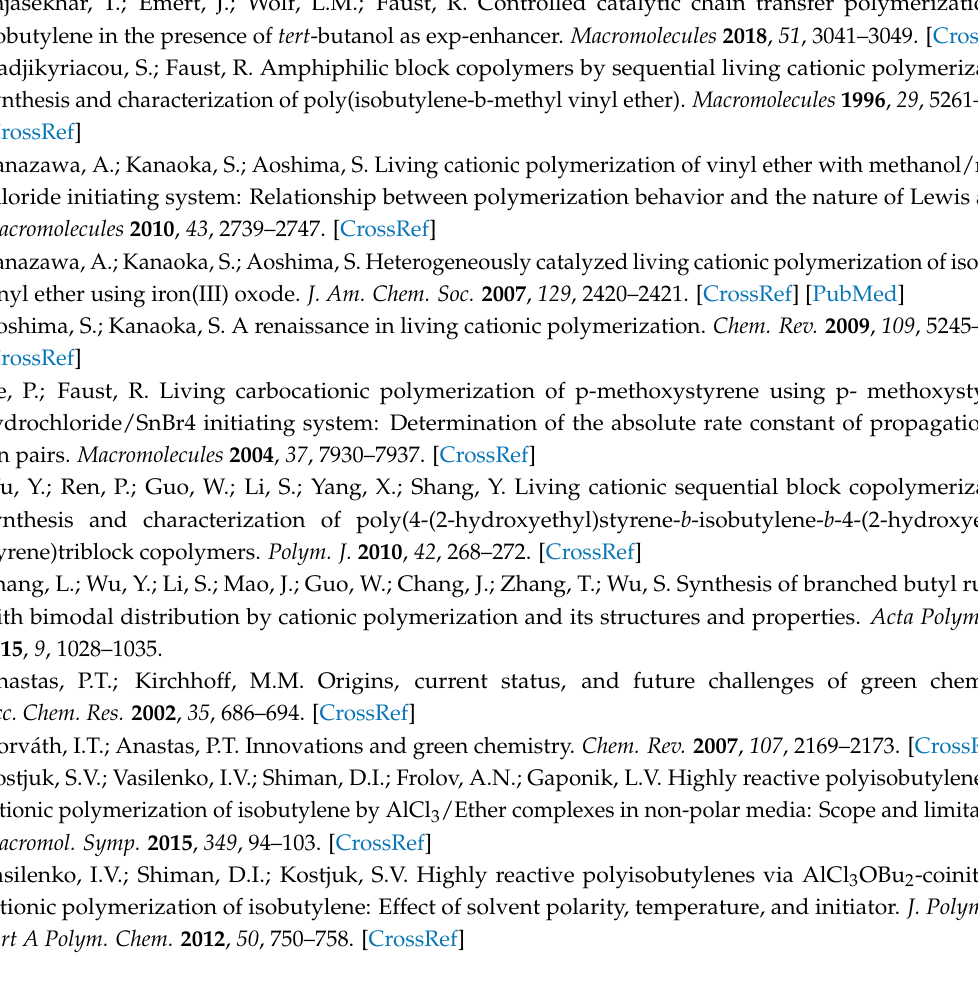
Figure S1: Suspension polymerization of styrene at 20 ◦ C: (a) conversion vs time; (b) ln[M 0 ]/[M] vs time. [St] = 1.75 M; [B(C 6 F 5 ) 3 ] = 0.05 M.; Figure S2: Styrene conversion at different polymerization temperatures initiated by CumOH/B(C 6 F 5 ) 3 in aqueous suspension for 50 h. [St] = 1.75 M; [CumOH] = [B(C 6 F 5 ) 3 ] = 0.05 M; NaCl: 1 g.; and Figure S3: Temperature during cationic polymerizations initiated by CumOH/B(C 6 F 5 ) 3 in aqueous emulsion at 20 ◦ C. [IBVE] = 1.6 M; [CEVE] = 2.0 M; [n-BVE] = 1.6 M; [CumOH] = [B(C 6 F 5 ) 3 ] = 0.05 M; CTAB =